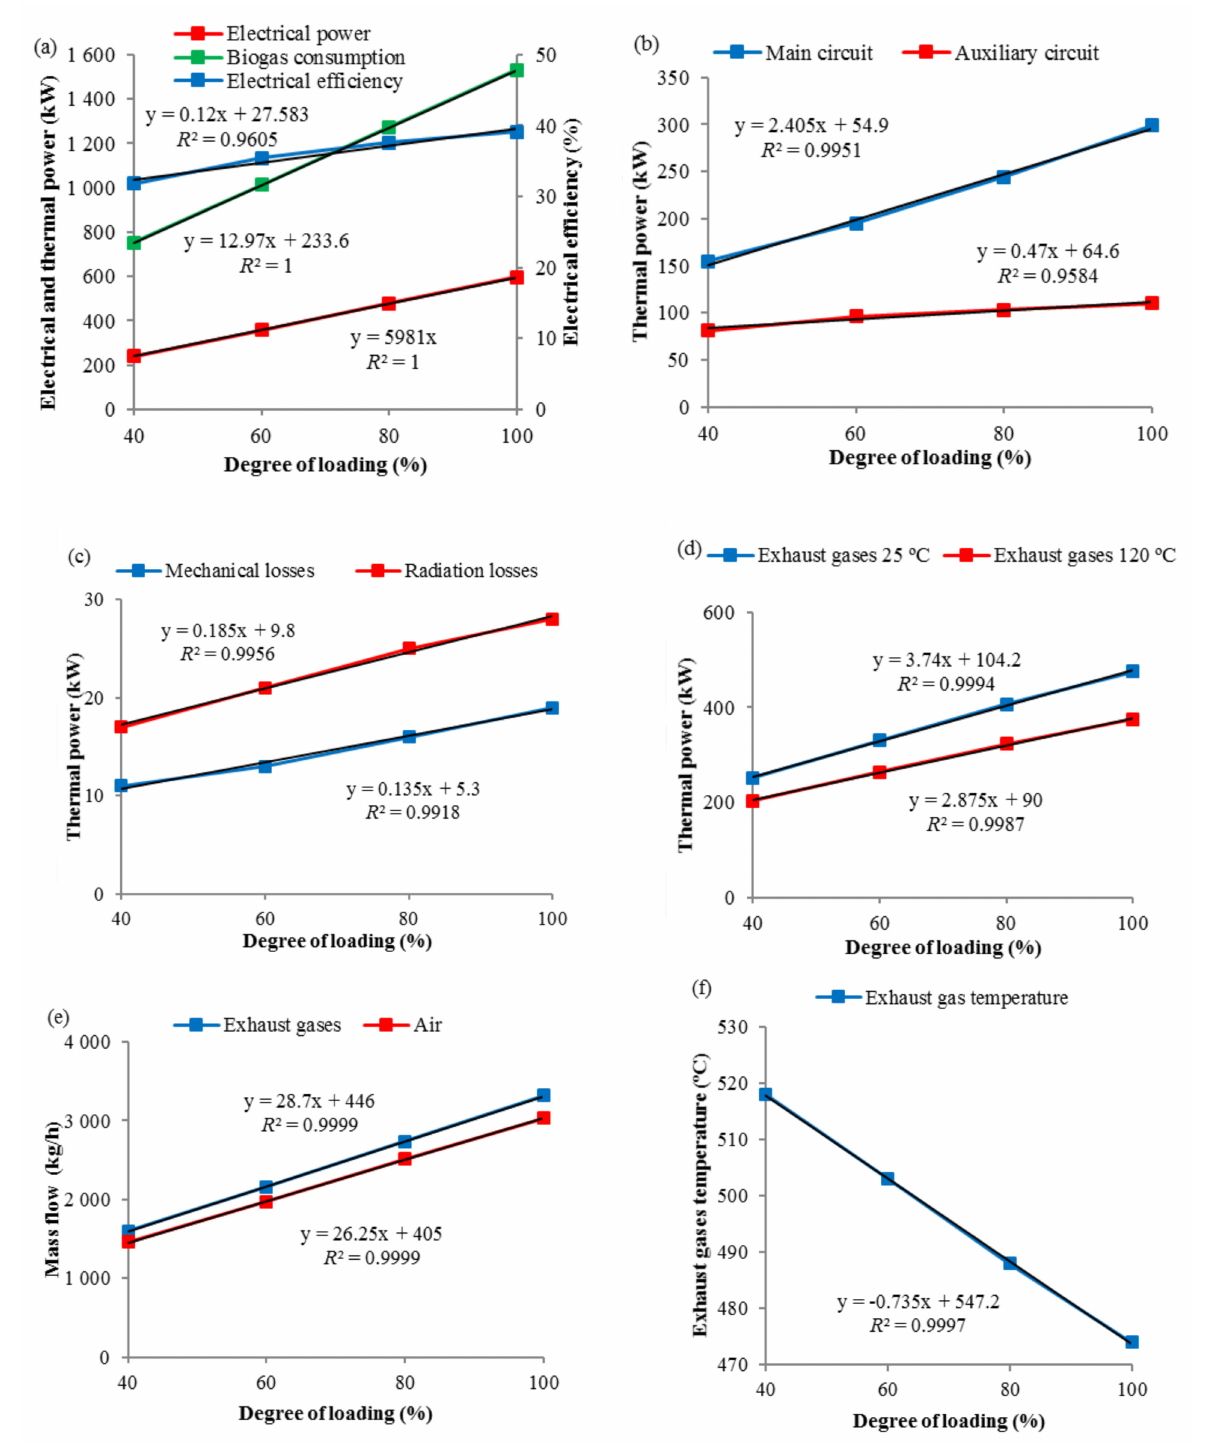
Figure 4. Sensitivity analysis of the engines’ parameters as a function of the degree of loading. ( a ) Electrical power, biogas consumption and electrical efficiency; ( b ) Thermal power in cooling circuits; ( c ) Mechanical and radiation losses; ( d ) Thermal power in exhaust gases at 25 and 120 ◦ C; ( e ) Mass flow of exhaust gases and air; ( f ) Exhaust gas